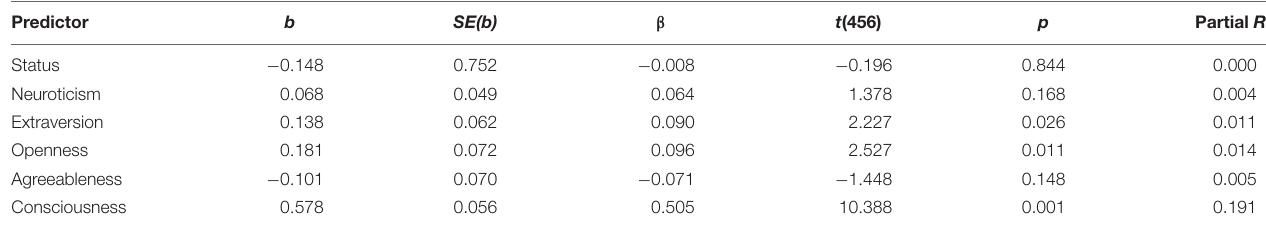
TABLE 3 | Results of the regression analysis predicting task-oriented coping. Predictor b